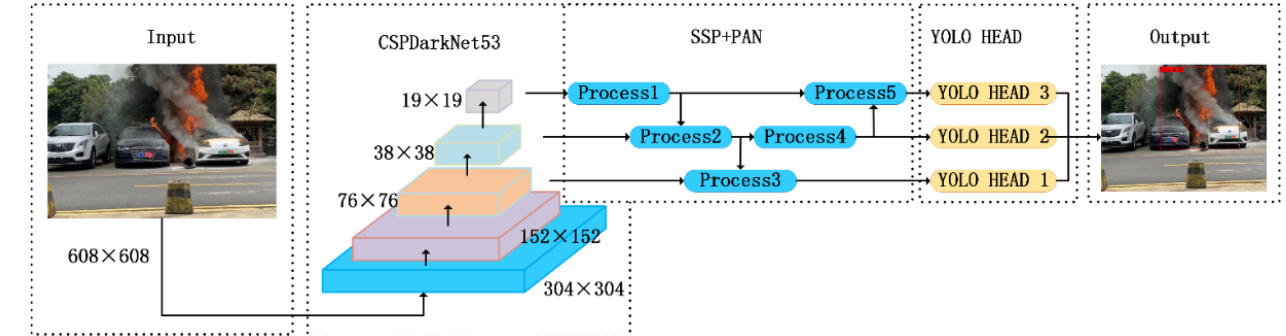
Figure 4. Fire detection model based on YOLOv4 for electric vehicle charging stations.